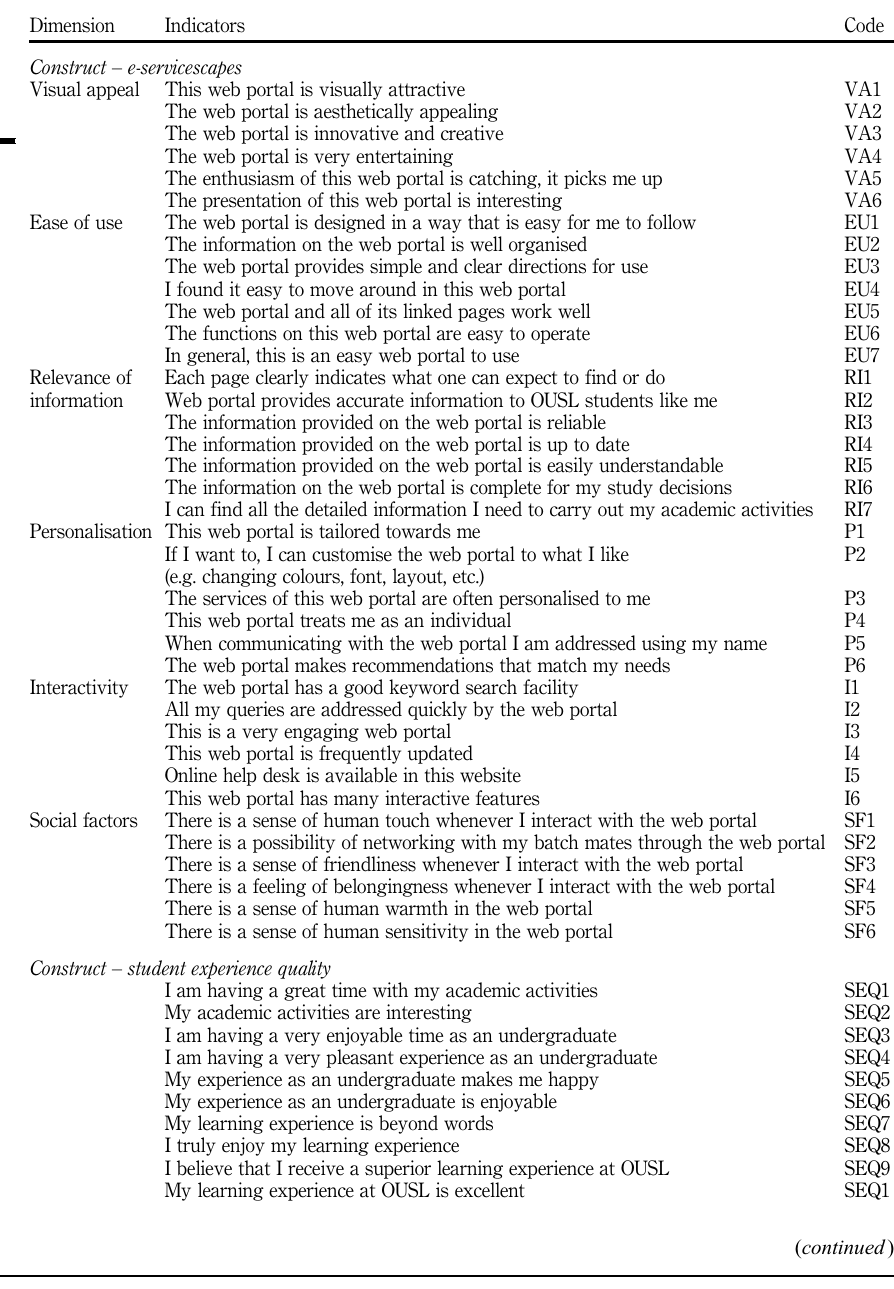
Table AI. Operationalisation of study